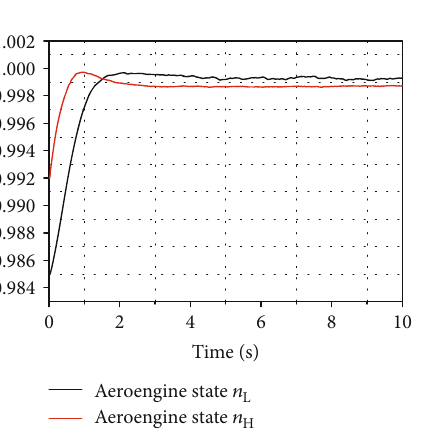
Figure 18: States and their estimations by